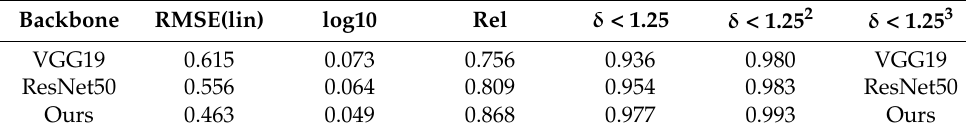
Table 6. Quantitative comparison results of different backbone networks.